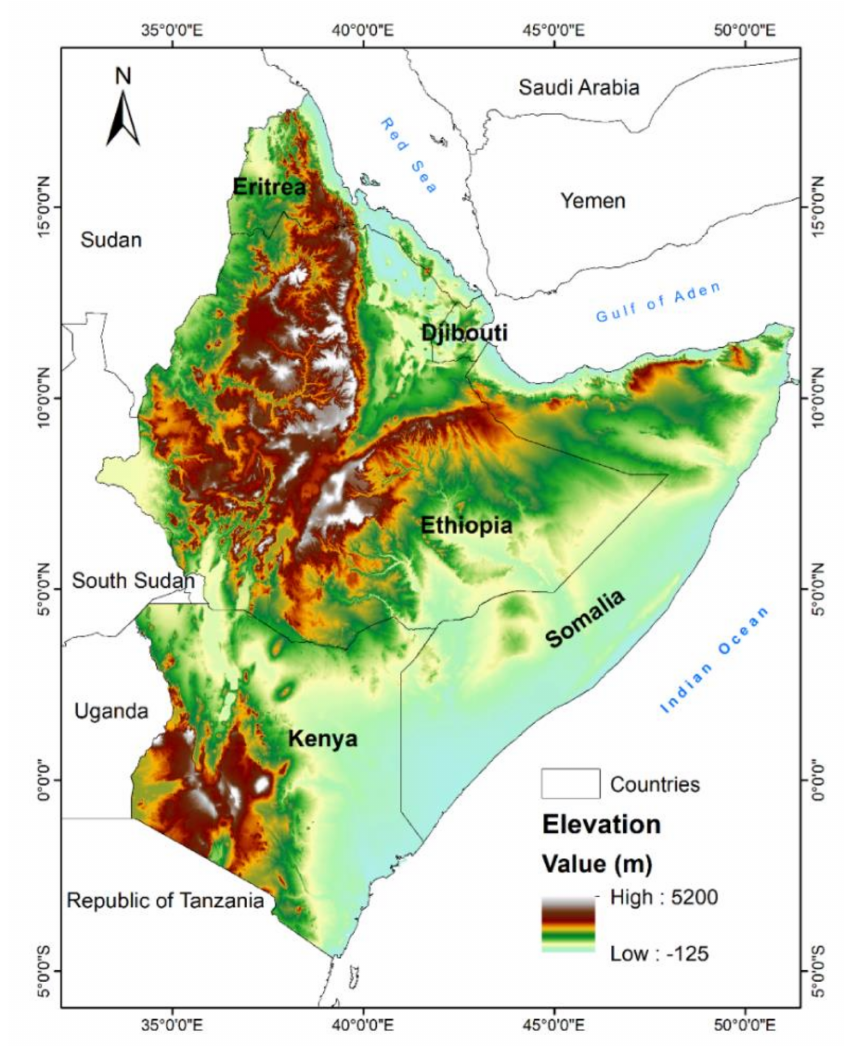
Figure 1. The elevation range in the Horn of Africa (DEM source: SRTM) and the countries within. The land cover can be generalized from the satellite image extractions. The European Space Agency land use/land cover data (2015) of 300 m spatial resolution shows that the most dominant land covers are shrublands, croplands (agriculture), forest areas, and grass- lands representing 38.9%, 20.4%, 14.1%, and 12.6%, respectively (Figure 2a). Grasslands and shrublands are dominant in southern parts of Ethiopia and Somalia, and northern parts of Kenya. Cropland land occupies large parts of the highland areas of Kenya, Ethiopia, and Eritrea. Agricultural activities, forests, and water bodies are more common in the western parts of the Horn of Africa and in the Rift Valley areas [30]. The most dominant agroecological zones in the Horn of Arica are of tropical climatic types which include warm arid, warm semi-arid, cool semi-humid, and cool semi-arid types covering 36.3%, 19.6%, 2.5%, and 1.2%, respectively (Figure 2b). The tropical warm arid zones are common in large parts of Somalia and Djibouti, western and eastern lowlands of Eritrea, and the eastern side of Kenya. Apart from the impact of climate change on terrestrial vegetation production and phenology, clearing forests and shrublands for the agricultural purpose by farmers is a common practice in some countries of the region, and this has increased the pressure on the land and endangered ecosystem services